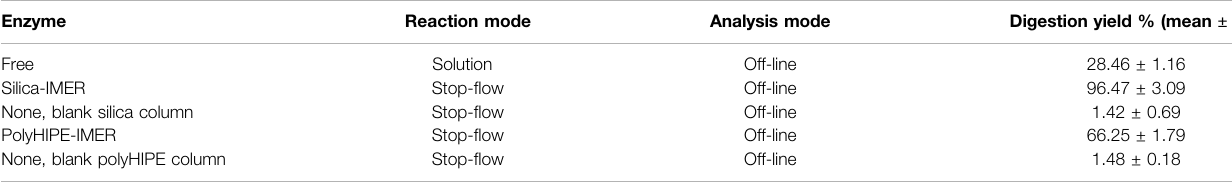
TABLE 4 | Results of the overnight digestion of 100 µL of 20 mM BAEE by papain in solution and in IMERs.